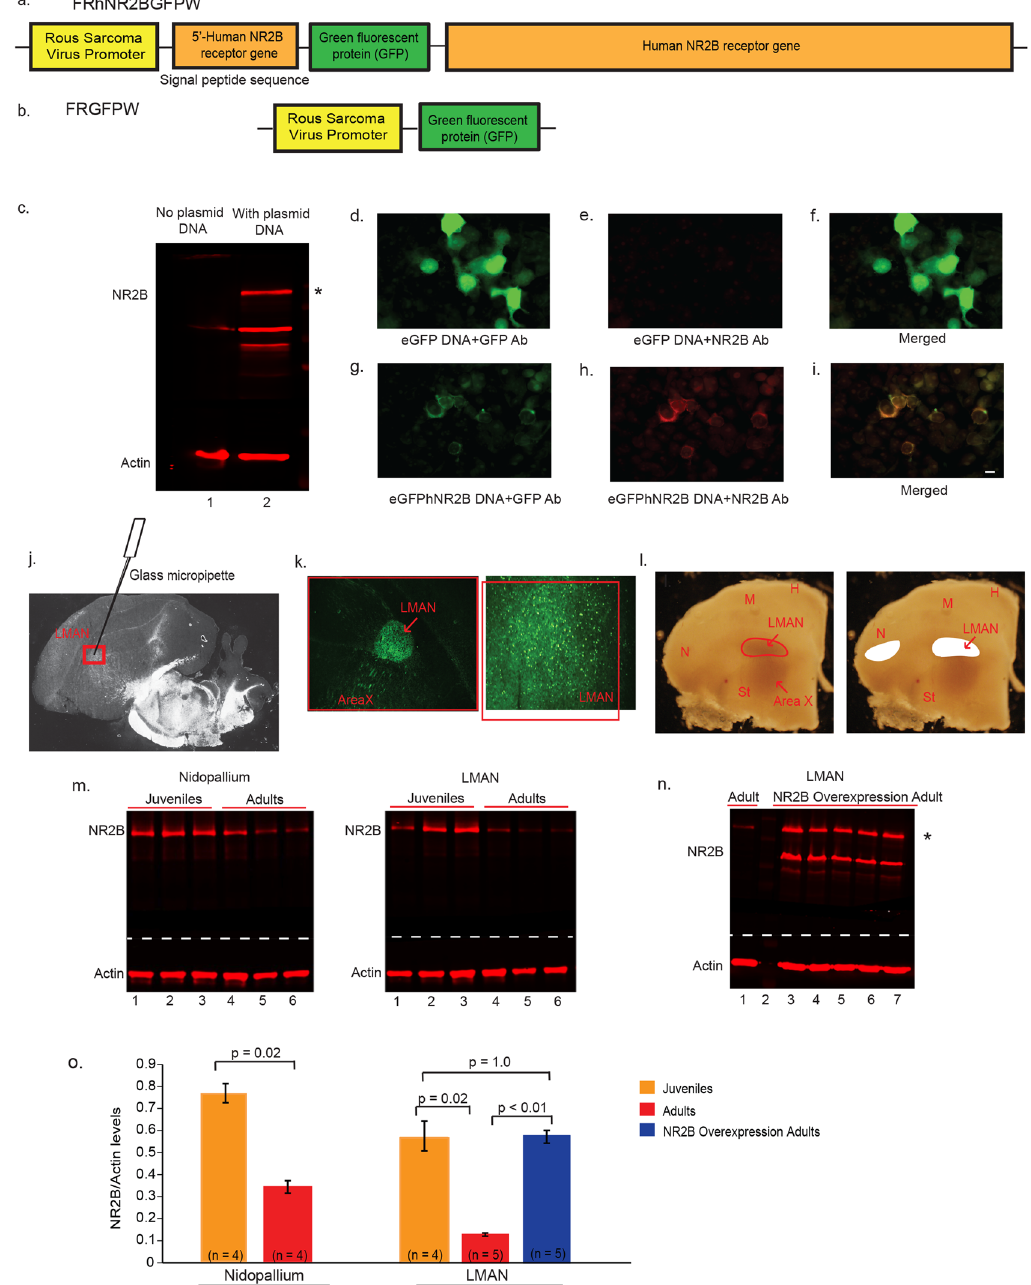
Figure 2. Design of lentiviral vectors for NR2B manipulation in LMAN. ( a ) Diagram of the eGFPhNR2B vector to overexpress human NR2B . ( b ) Diagram of the eGFP vector for control injections. ( c ) Western blots showing no human NR2B protein in HEK293FT cells without transfection (Lane 1), and greater NR2B protein ( * ~180 kD band) in cells transfected with the eGFPhNR2B plasmid (possible degraded or unfinished NR2B protein product is detected as an additional lower band) (Lane 2). ( d ) HEK293FT cells transfected with the eGFP plasmid show GFP-expressing cells labeled using a GFP antibody (green). ( e ) Cells transfected with the eGFP plasmid stained with an anti-NR2B antibody show no labeled cells. ( f ) Merged image of ( d ) and ( e ). ( g ) Cells transfected with the eGFPhNR2B plasmid show GFP-expressing cells (localized in cell membranes) labeled using a GFP antibody (green). ( h ) Cells transfected with the eGFPhNR2B plasmid show NR2B-expressing cells (localized in cell membranes) stained with anti-NR2B antibody (red). ( i ) Merged image of ( g ) and ( h ) showing complete overlap of the human NR2B tagged with eGFP (yellow). ( j ) Darkfield view of a brain section showing the injection site in LMAN. ( k ) Cells expressing GFP-tagged (green) human NR2B ~3 weeks after injection of the eGFPhNR2B lentivirus in LMAN. ( l ) Darkfield photograph of coronal sections showing drawings of LMAN and part of nidopallium that was microdissected for protein analysis. ( m ) Western blots showing NR2B protein and actin protein from microdissected tissues of nidopallium and LMAN in juveniles and adult animals (3 animals shown as examples). ( n ) Western blot comparing endogenous NR2B protein and actin in LMAN of an adult bird (Lane